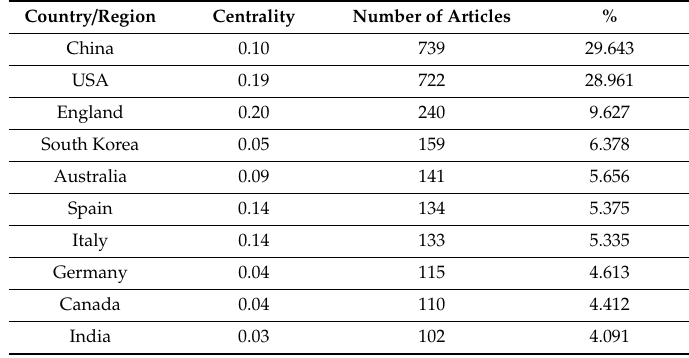
Table 3. Top 10 countries by number of